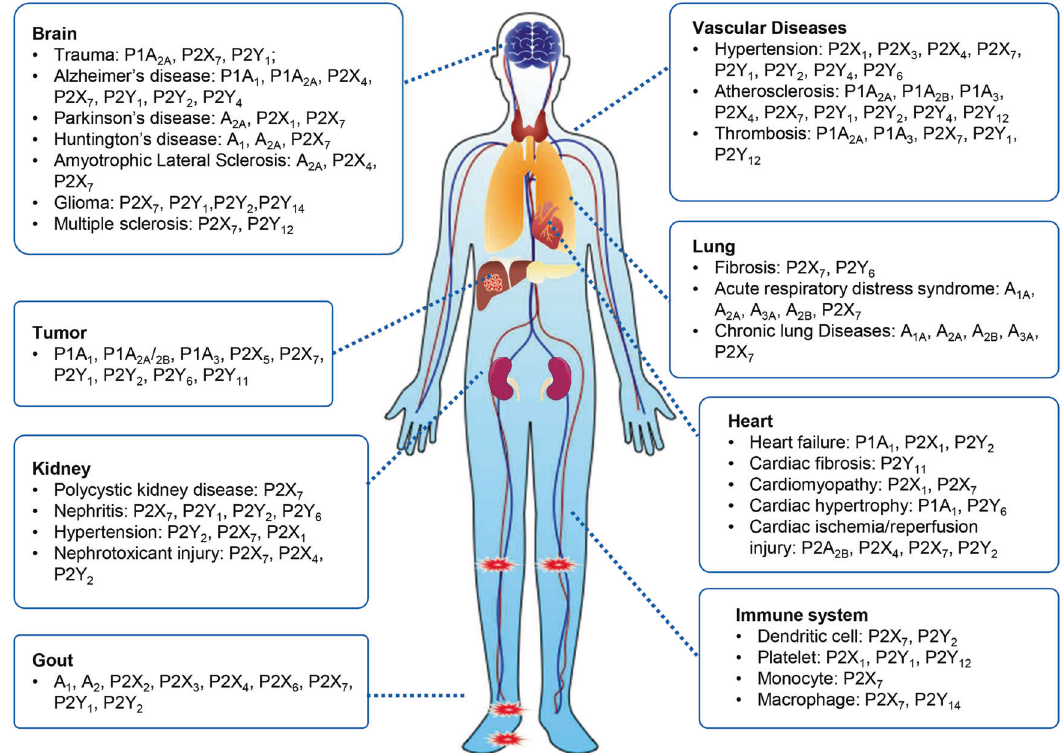
Fig. 1 The causative role of purinergic signalling in human diseases. Purinoceptors, including P1, P2X and P2Y receptors, are diffusely expressed in every human body part, such as the nervous system, circulatory system, respiratory system, immune system, urinary system and others. Dysregulation of purinoceptors function leads to various diseases, including neurological, rheumatic, cardiovascular, cancer diseases and so